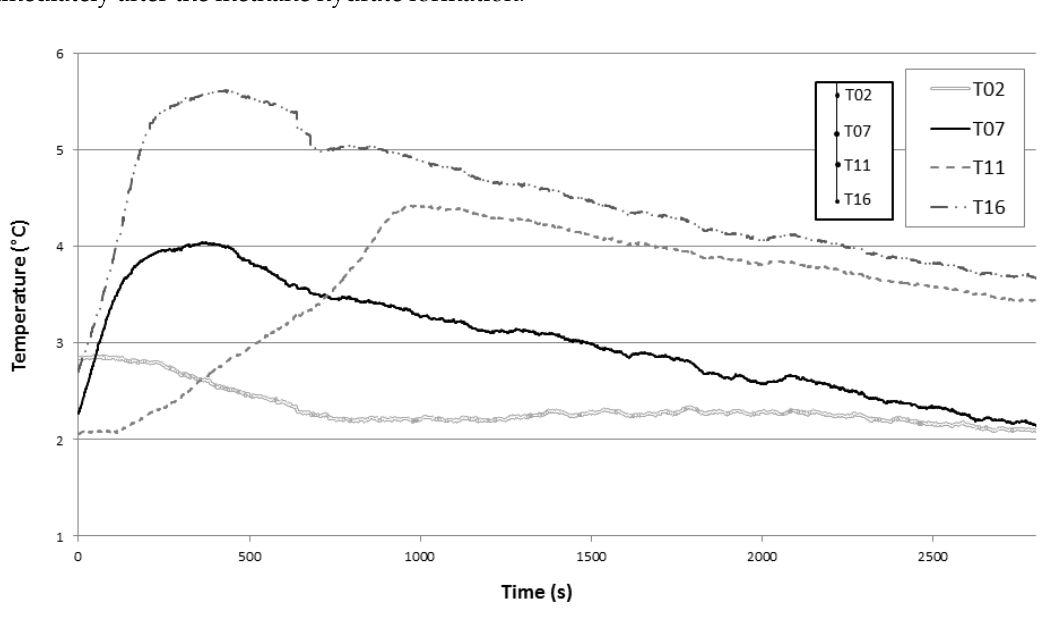
Figure 9. Temperature trend in the reactor during the CO 2 replacement phase.